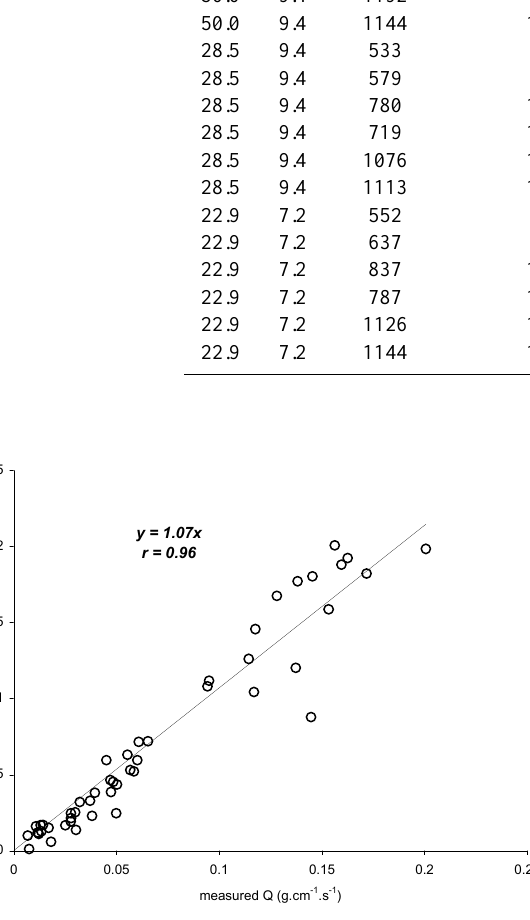
FIGURE 5 Fig. 5. Comparison between calculated and measured erosion fluxes for the eight ridges data sets